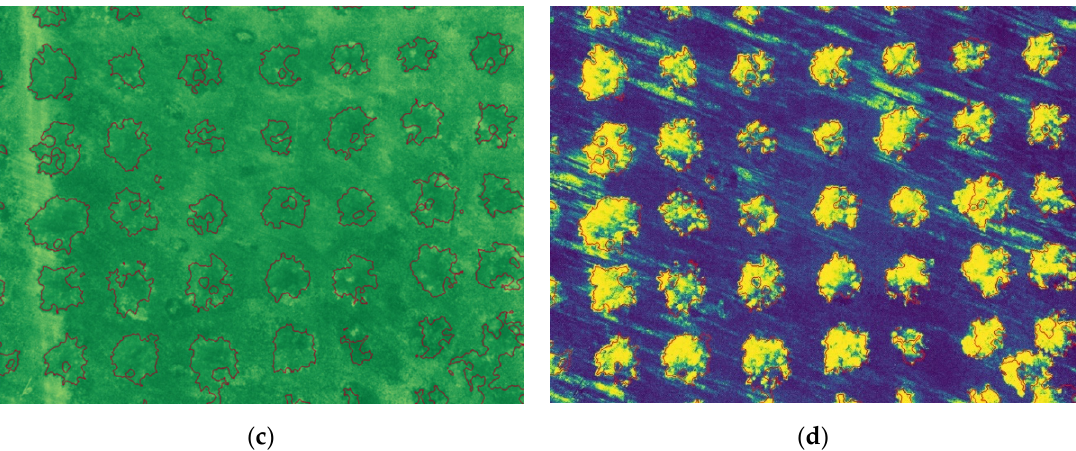
Figure 14. ( a ) Segmented RGB image; ( b ) segmented CIR image; ( c ) NDVI image; ( d ) probability map. The blue arrow in the upper left corner of ( a ) indicates a classification error.